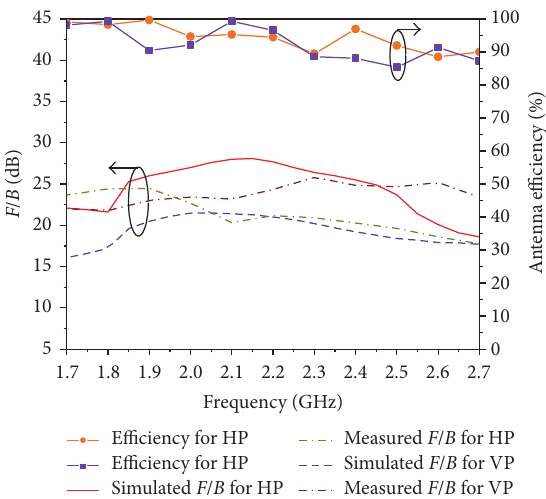
Figure 5: Front-to-back ratios and antenna efficiency of the broadband V/H dual-polarized